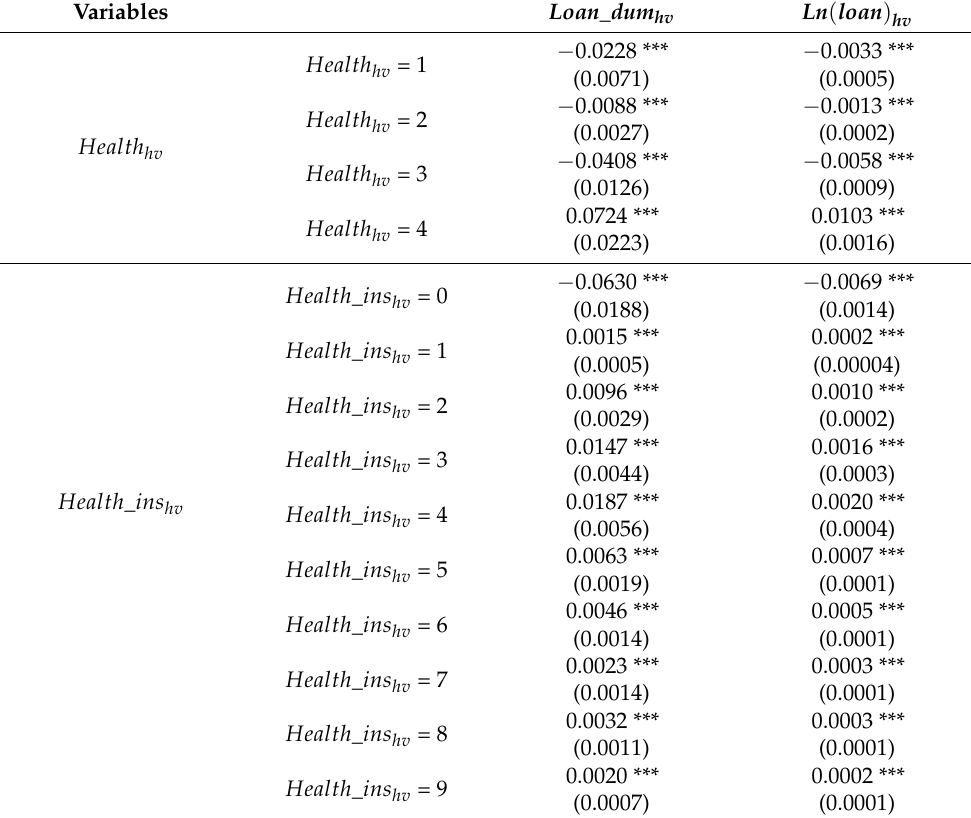
Table 3. The marginal effects of microcredit on rural residents’